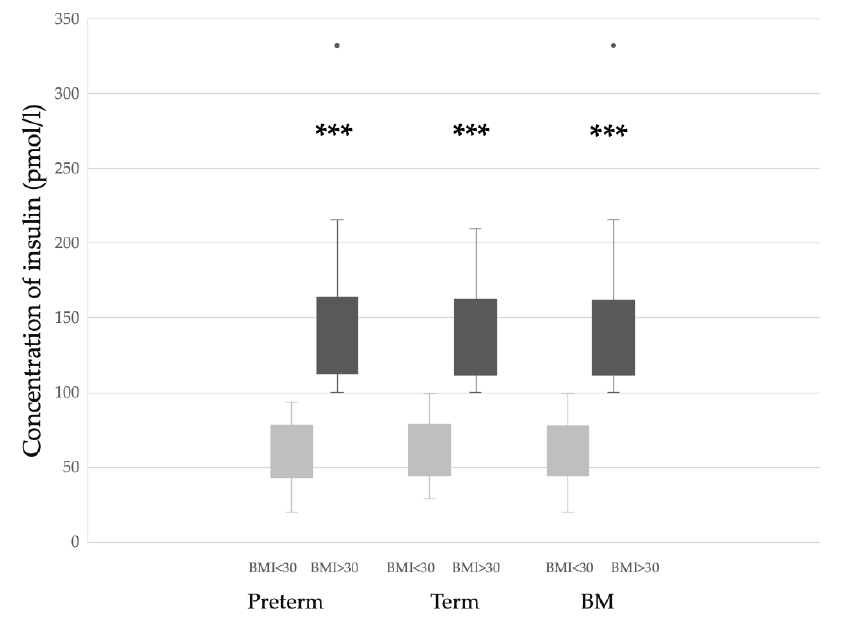
Figure 2. Impact of BMI on the insulin concentration of preterm or term breast milk and the com- bined group of breast milk (BM) samples.  p < 0.001 versus BMI 